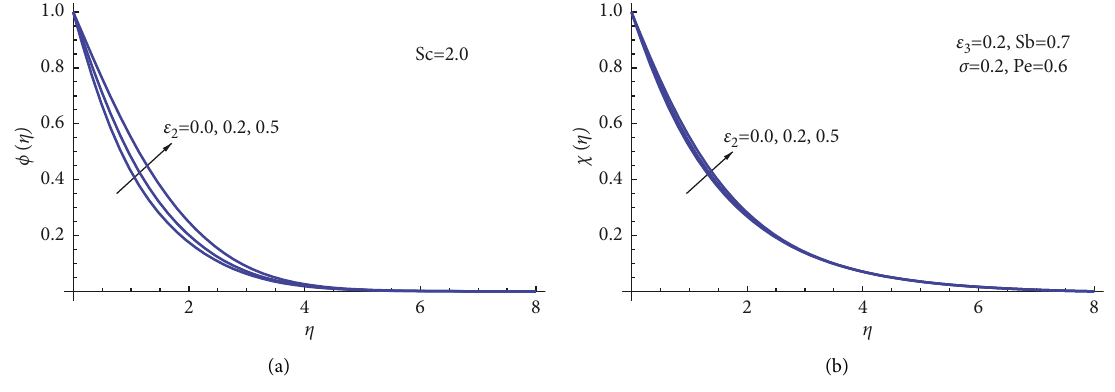
Figure 10: (a) Impact of ε